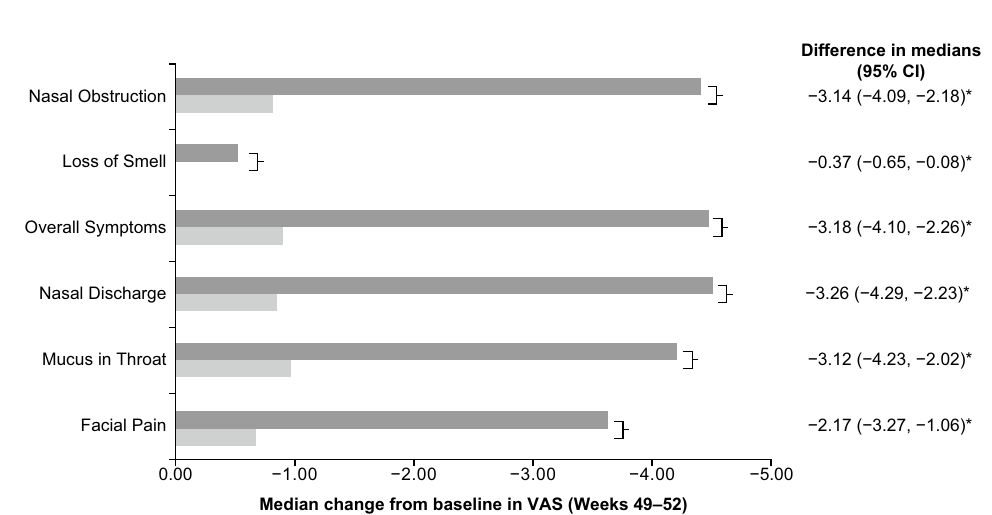
Fig. 5 Change from baseline at Weeks 49–52 in individual VAS scores. * P < 0.001. CI Confidence interval, VAS Visual analogue